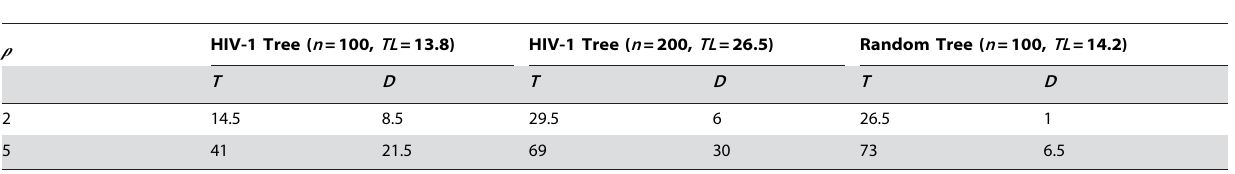
Table 2. The effect of tree length and shape on the power to detect amino acid toggling.